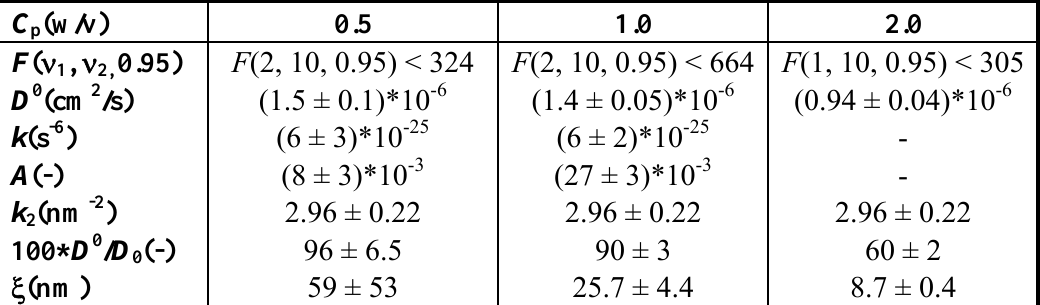
Table 2. Model best fitting parameters ( D 0 , k , A ) and derived parameters ( ξ , D 0 / D is the diffusion coefficient of myoglobin in water (37°C) referred to the release data. D 0 [11], n (= 6) is Equation (15) exponent while F indicates “ F-statistic ” parameter. Values are reported as mean ± standard